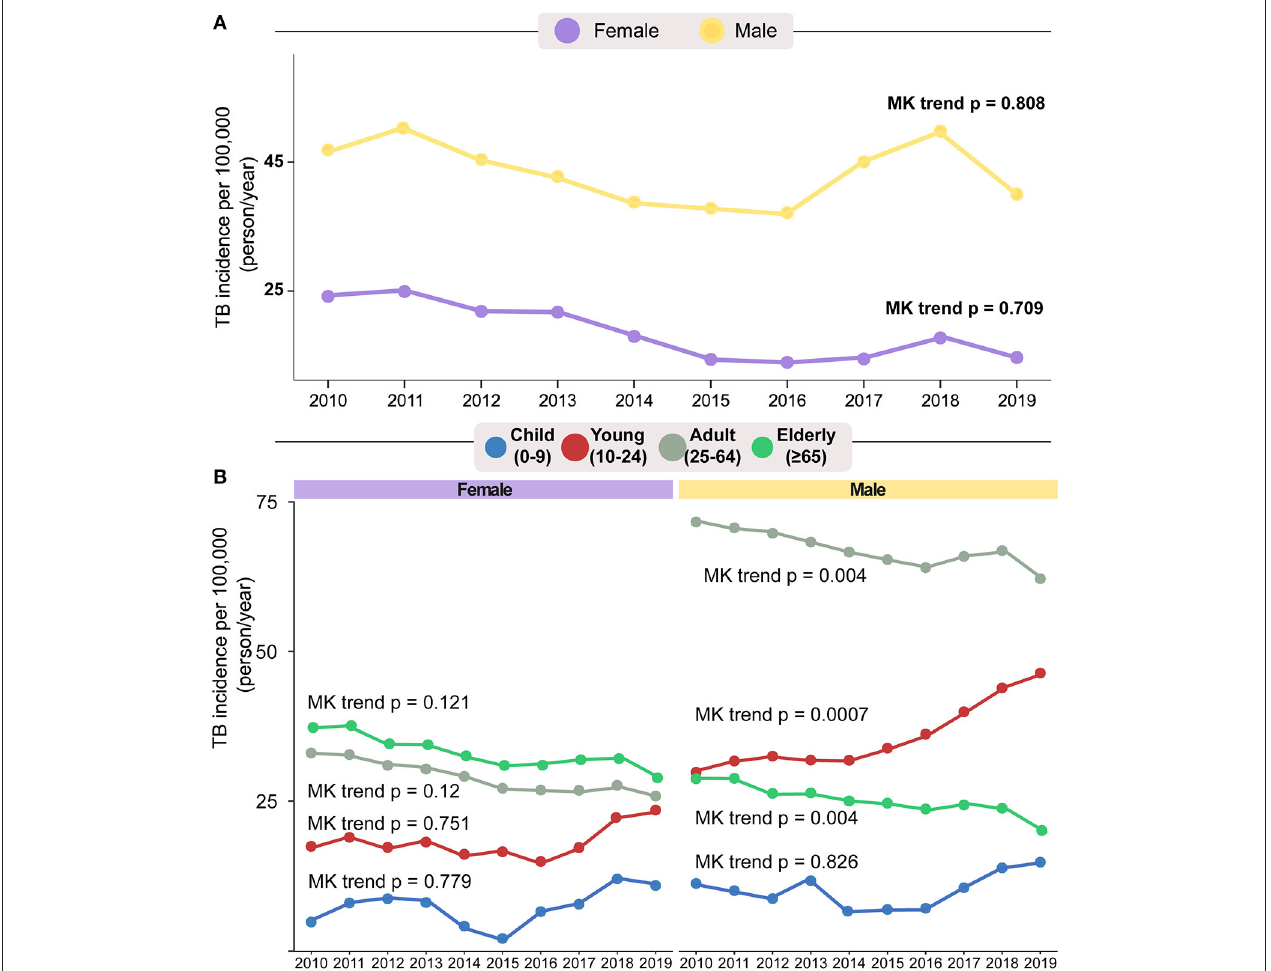
FIGURE 1 | General population TB rates by sex (A) and age group (B) between 2010 and 2019. Mann–Kendal trend test was used to calculate changes in incidence among years. According to sex and/or age group, on panel (A) , it is possible to observe that there was a small decrease in the incidence of women with tuberculosis (purple). In age stratification (B) , only the incidence in children has not changed over the years. Age Groups: Children (0–9.9 years); young (10–24.9 years); Adults (25–64.9 years); Elderly ( ≥ 65